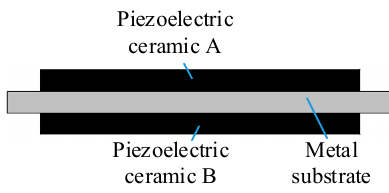
Figure 2. Schematic of the piezoelectric bimorph vibrator .